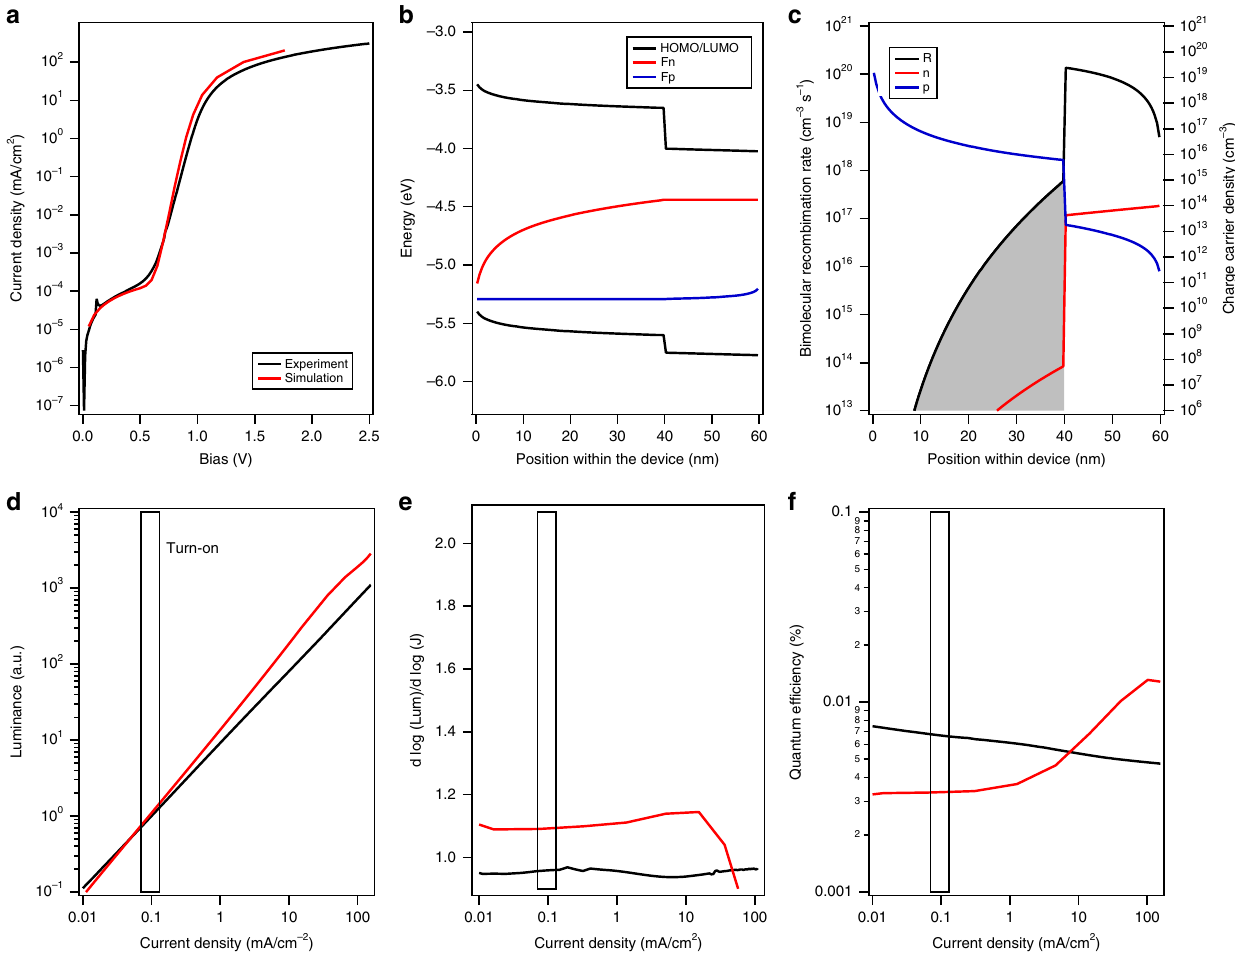
Fig. 7 Drift diffusion modeling. Simulated and experimental J ( V )-characteristics of a rubrene/C60 ( 40 nm/20 nm) heterojunction ( a ). Also shown are the band diagram ( b ) and the bimolecular recombination rate within the device ( c ) at 0.8 V. L ( J ), ∂ log( L )/ ∂ log( J ), and the internal quantum ef fi ciency are shown in d – f . In case of the simulation, the internal quantum ef fi ciency, and in case of the experimental data, the external quantum ef fi ciency are shown. Note all recombination within the device is bimolecular recombination of free charge carriers. The simulation included a series resistance of 25